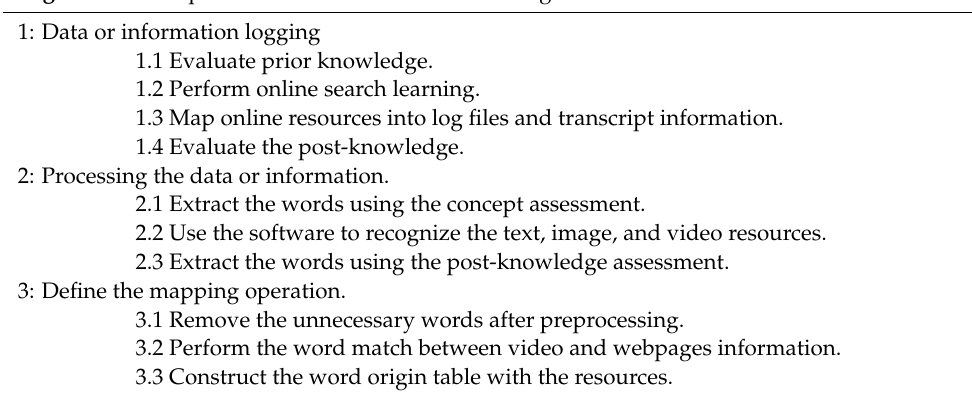
Algorithm 1: Proposed Model—Resources